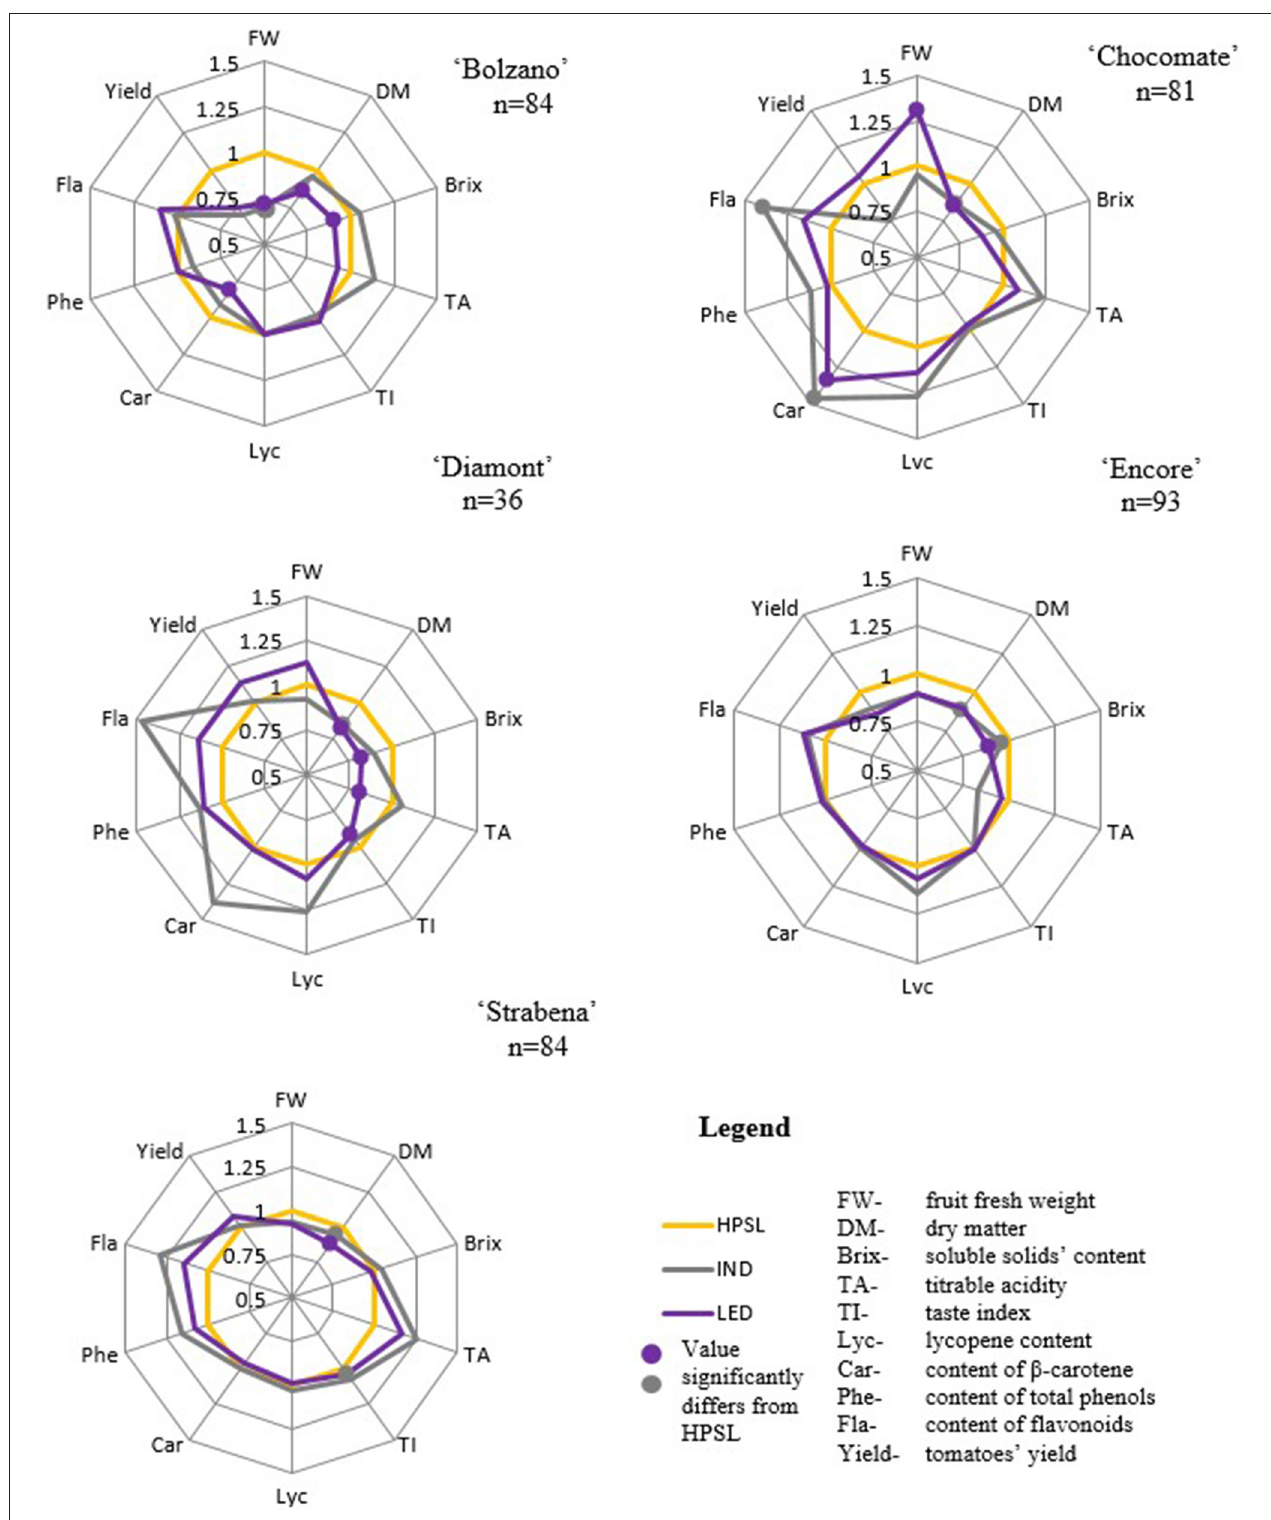
FIGURE 9 | Ratio of the obtained parameters under supplemental light-emitting diode (LED) and induction (IND) lamps to high-pressure sodium lamp (HPSL).